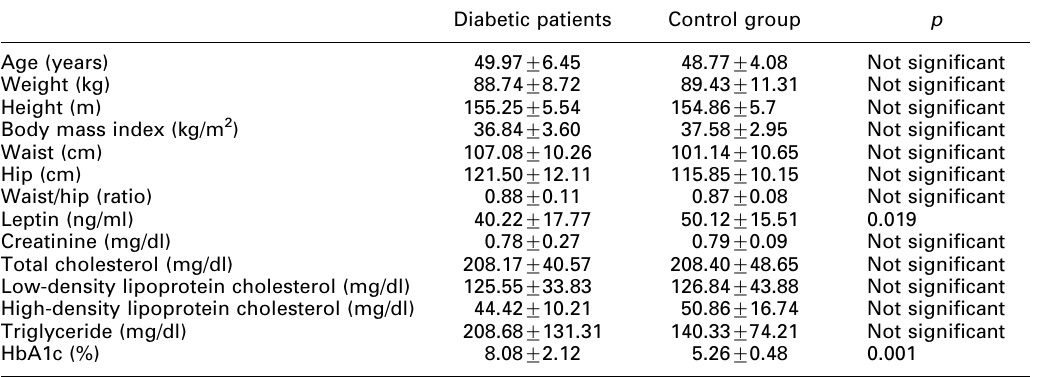
Table 1. Baseline characteristics and biochemical parameters of subjects with diabetes and the control group